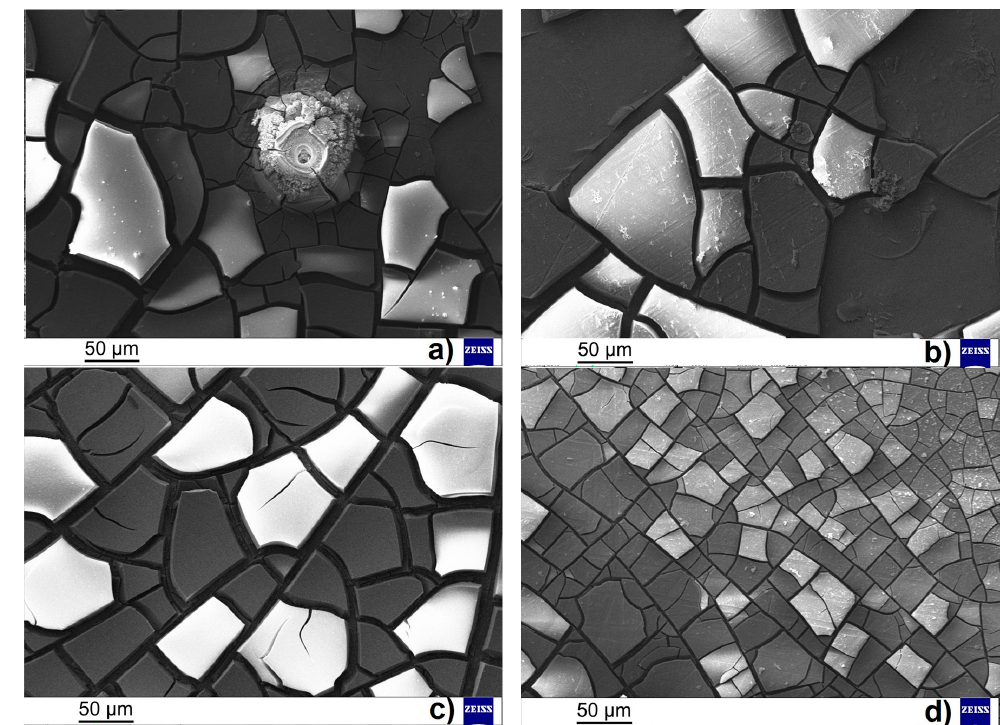
Figure 7. Morphology of the surface after EIS (electrochemical impedance spectroscopy) measurements (168 h of immersion in HBSS without Mg 2+ and Ca 2+ ions): ( a ) AZ31—0.25 µm, ( b ) AZ31—#1200, ( c ) AZ61—0.25 µm and ( d ) AZ61—#1200.